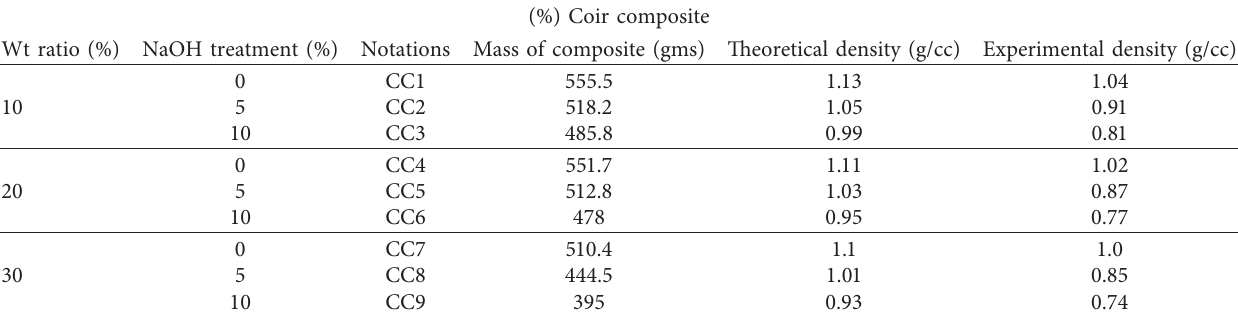
Table 3: Estimated density and mass of coir fiber reinforced composite using the rule of mixture. (%) Coir composite